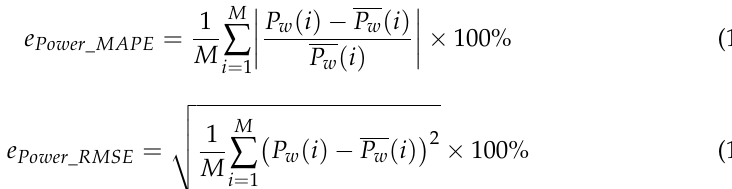
Table 5. Six case settings considering different parameter C 4 ε values. Case